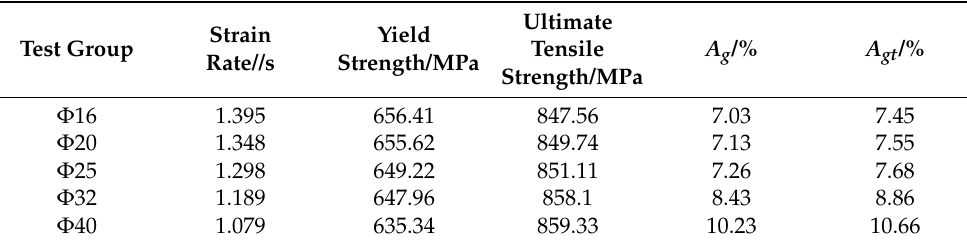
Table 6. Mechanical indexes of specimens under different strain rates.